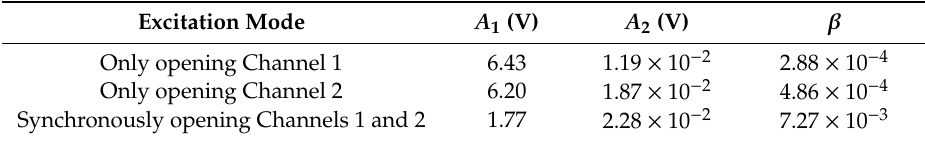
waves in di ff erent